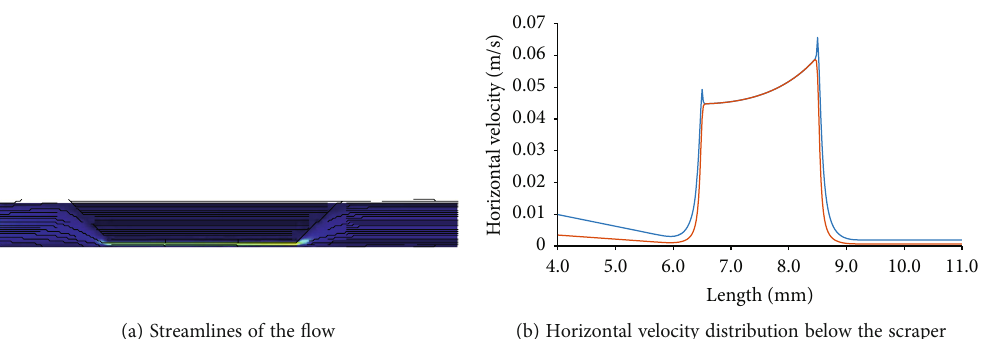
Figure 9: Simulation result of the third situation.